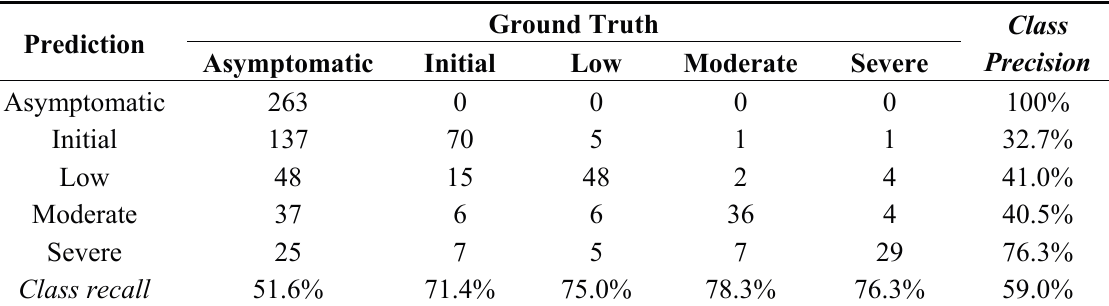
Table 5. Confusion matrix for Verticillium wilt severity classes using the linear discriminant classification based on the indices selected by the forward stepwise discriminant analysis.